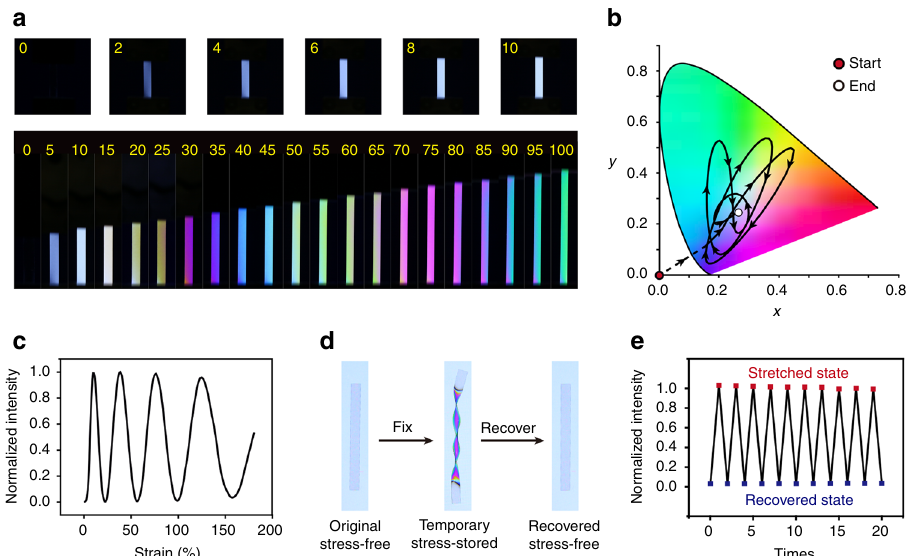
Fig. 2 Stress and mechanical color via elastic deformation at 60 °C. a Color change during uniaxial stretching at a strain rate of 50% min − 1 (numbers in yellow denoting strains in percentage). b Color evolution during continuous stretching from 0 to 180%, presented at a standard CIE-1931 color space. c Cyclic change of the light intensity (450 nm) corresponding to b . d Photographs (under bright fi eld) of a sample underwent a shape memory cycle (sample length: 4 cm). e Light intensity change upon cyclic shape memory experiments (10% strain, 450